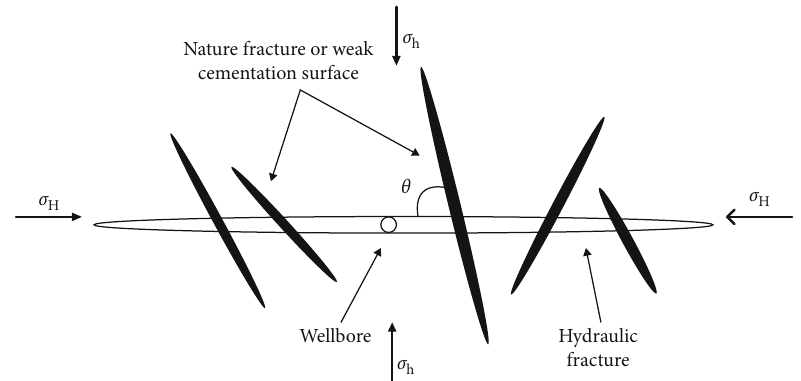
Figure 2: Schematic diagram of a naturally fractured reservoir fracture network.